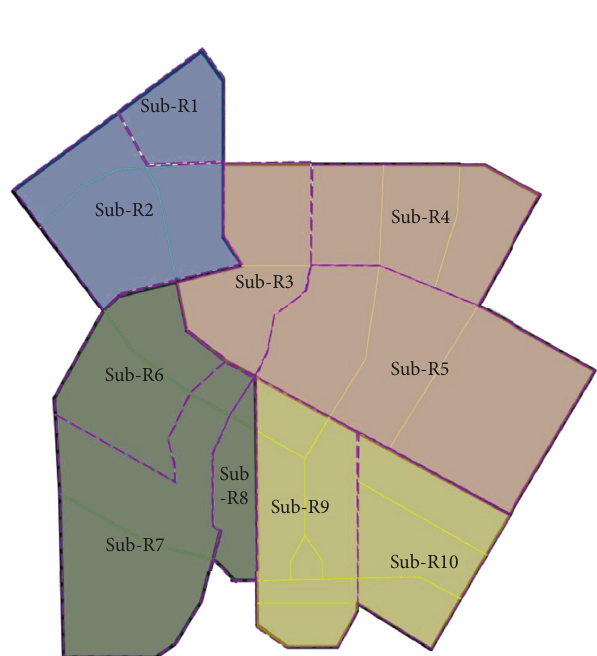
Figure 10: The topology of the network at the sub-region